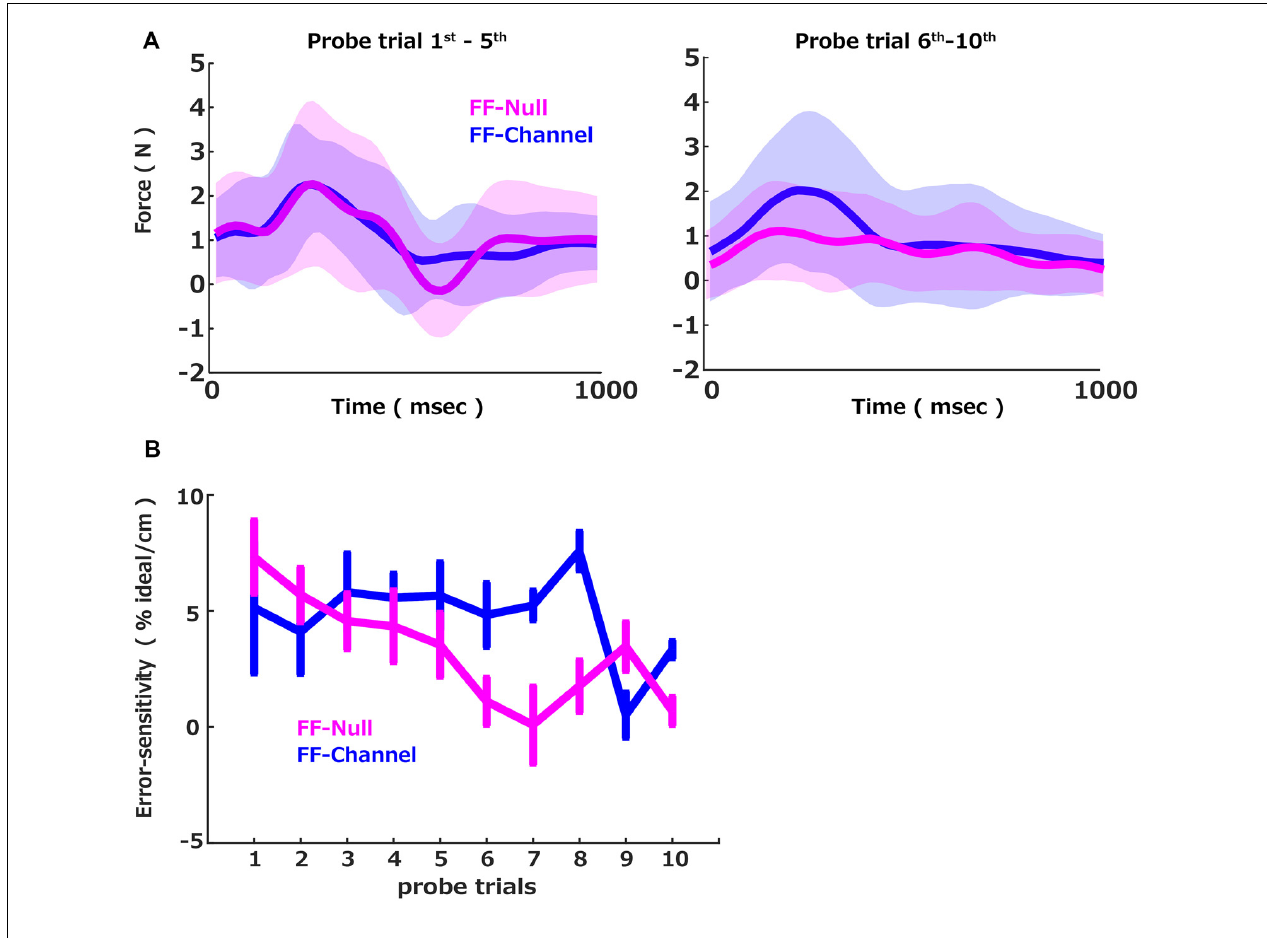
FIGURE 2 | Force profiles and error-sensitivity. (A) The across participants average of the measured difference in the perpendicular force between the pre-perturbation error clamp trial and the post-perturbation error clamp trial. Average (solid) and standard deviation (shadow) across participants in each group (FF-Null: magenta, FF-Channel: blue) computed for the average of the first five (left) and the last five probe trials (right). (B) The group averages of the error-sensitivity across cycles measured by the probe trials were plotted over probe trials. The error bar indicates the standard